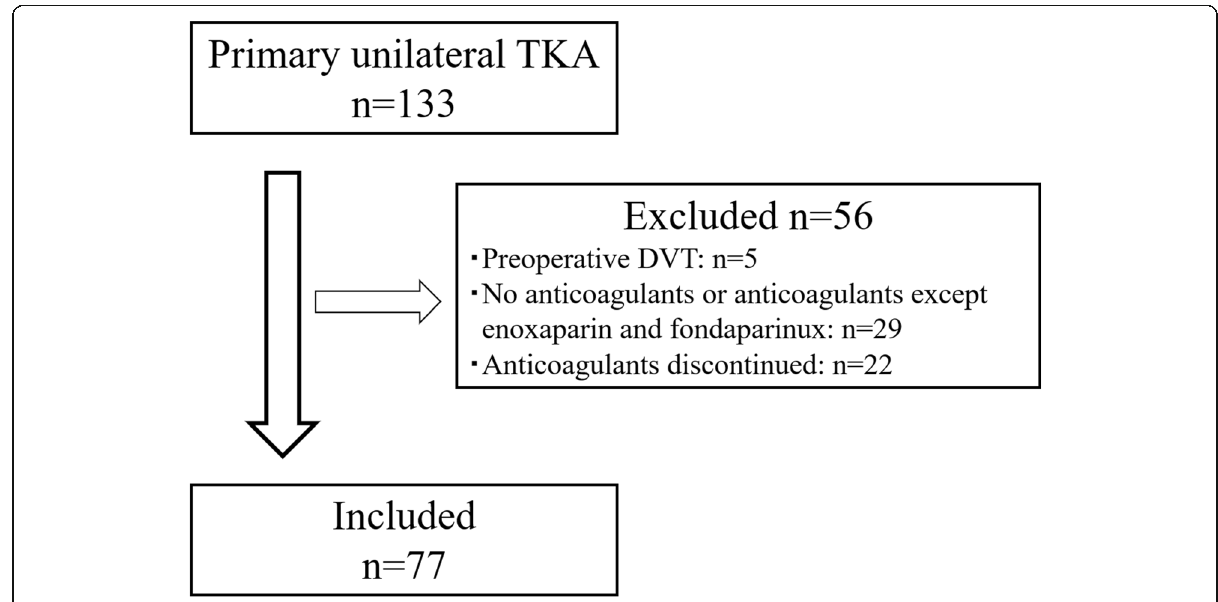
Fig. 1 Flow diagram of patients analyzed in this